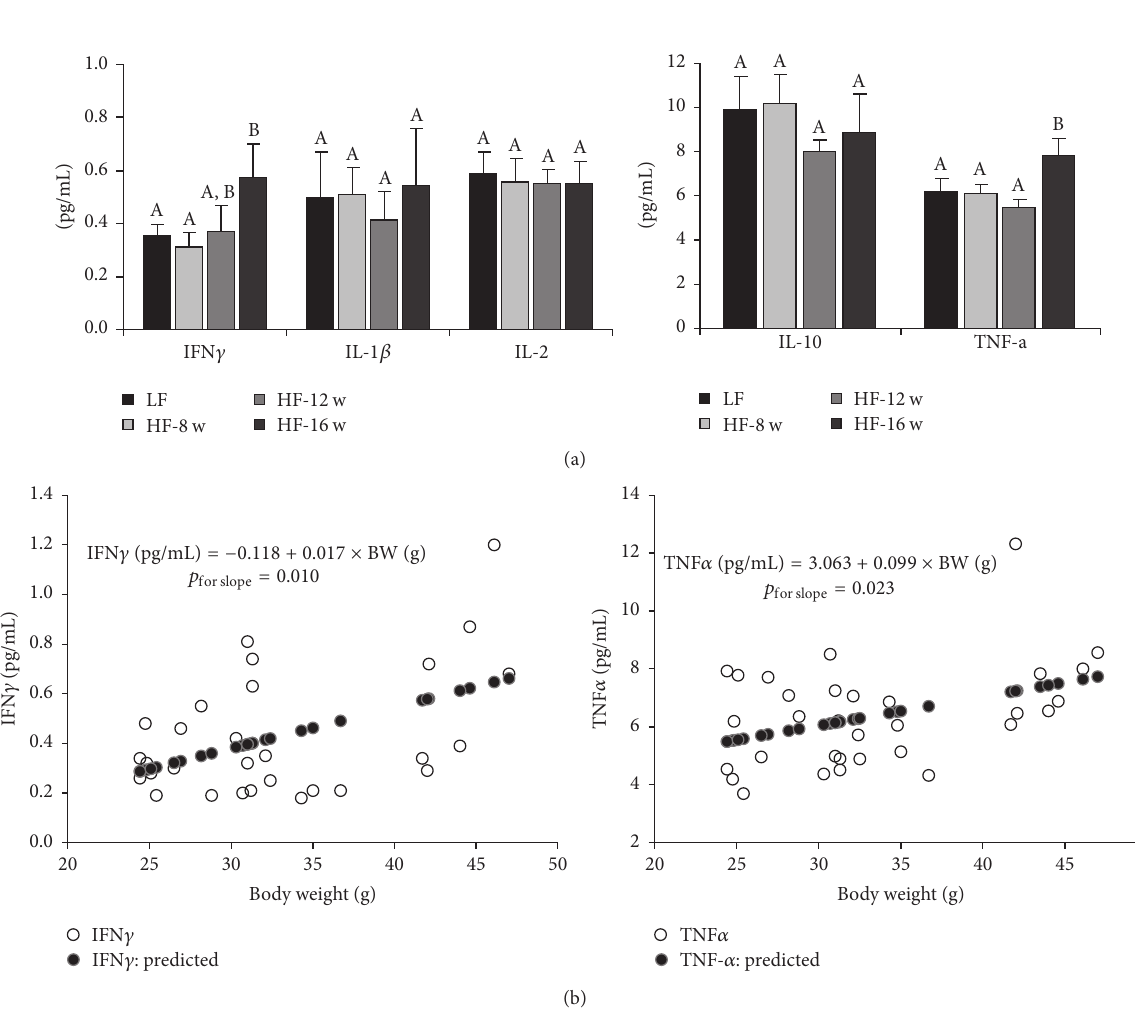
Figure 6: Effect of high fat diet consumption on circulating inflammatory cytokine profile. (a) Serum inflammatory cytokine levels across the groups. (b) Pearson’s correlations of IFN 𝛾 and TNF- 𝛼 with body